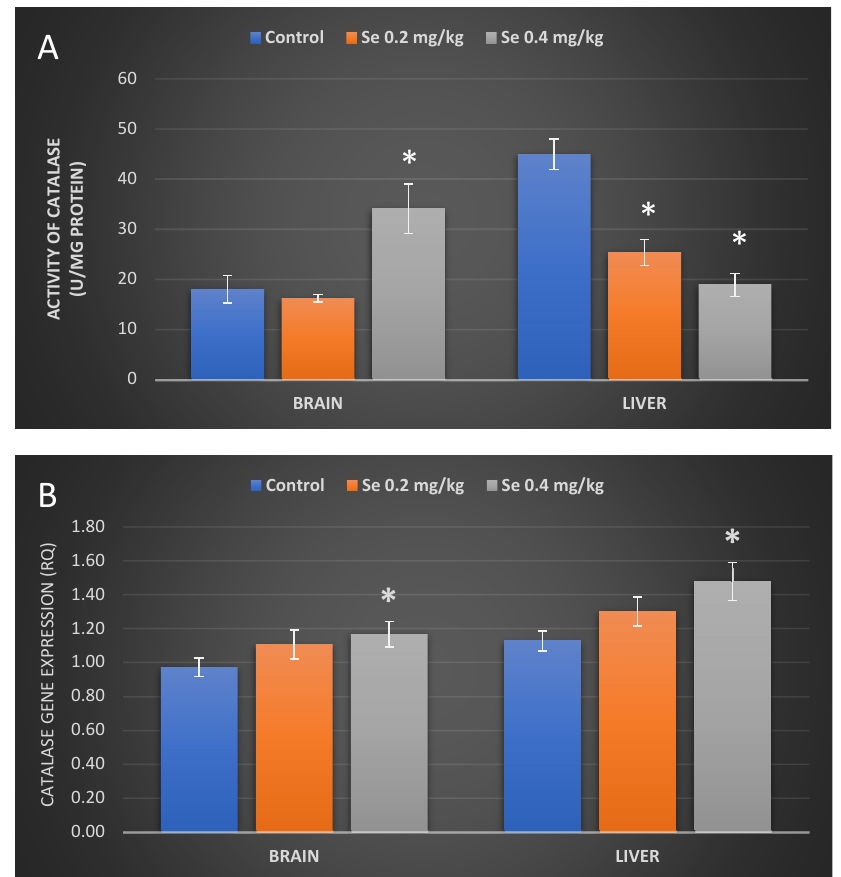
Figure 4. Activity of catalase ( A ) and relative expression of CAT gene ( B ) in mice brain and liver of the control group mice and mice orally treated with a Na 2 SeO 3 solution for 8 weeks. The model of selenium exposure to mice is described in the Methods section. Data represent the results of eight separate experiments. Results are expressed as the mean ± SEM. *—differences are statistically significant in comparison to the control group; p < 0.05.